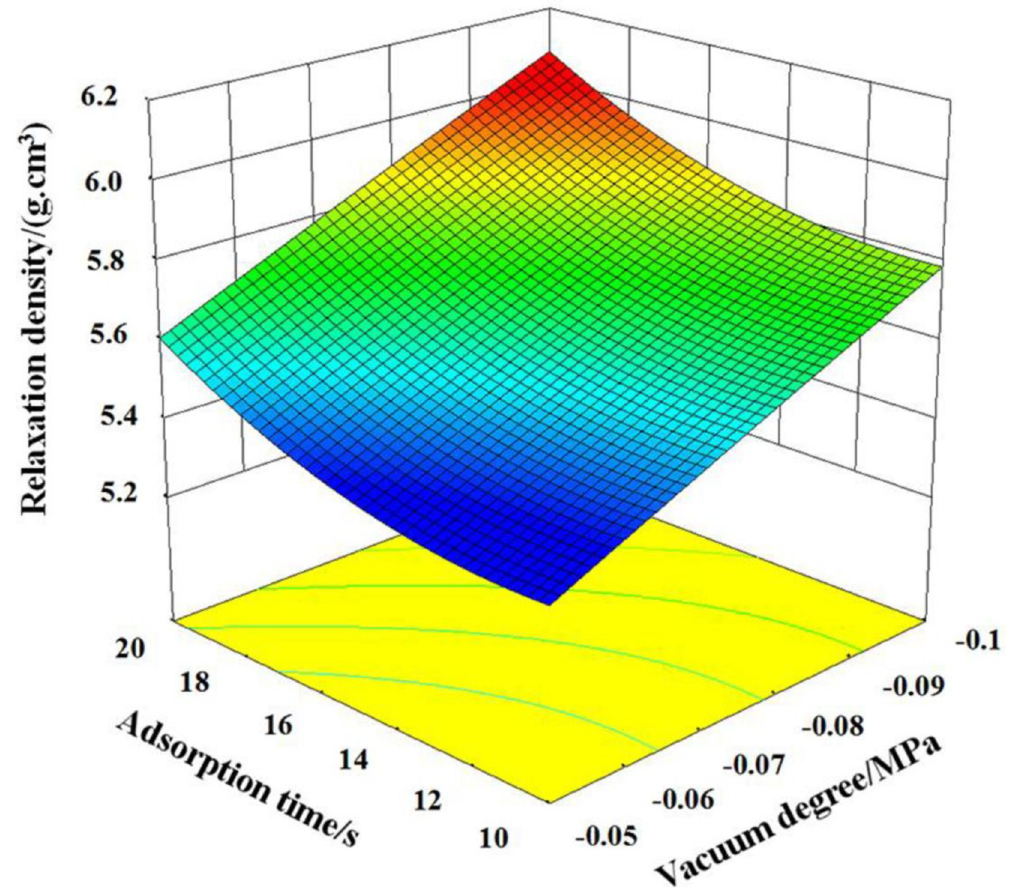
Fig 9. The interaction of the adsorption time and vacuum degree on the relaxation